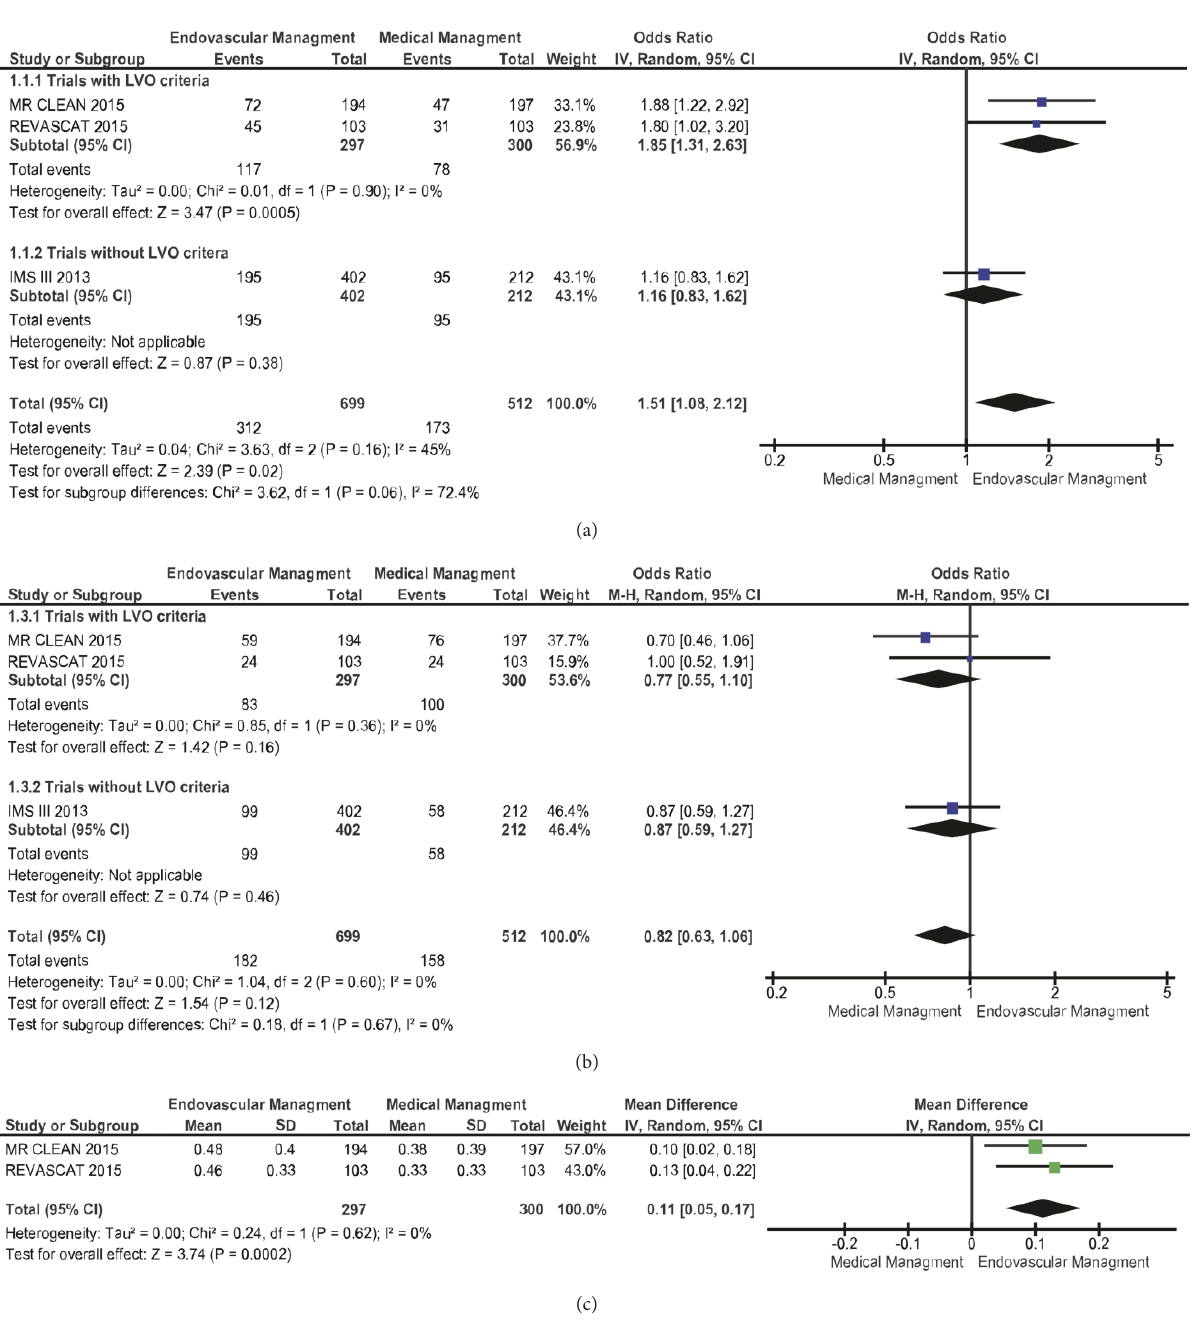
Figure 4: Functional independence (mRS 0-2), mortality (mRS 6), and quality of life at long-term follow-up following endovascular or medical management of AIS due to LVO . Forest plot of odds ratios (ORs) or mean difference for (a) functional independence (modified Rankin score or mRS 0-2), (b) all-cause mortality, (c) and quality of life (EQ-5D utility) at long-term follow-up. Estimated ORs and confidence intervals are shown, respectively, by the square box and horizontal line. Heterogeneity tests and effect size are